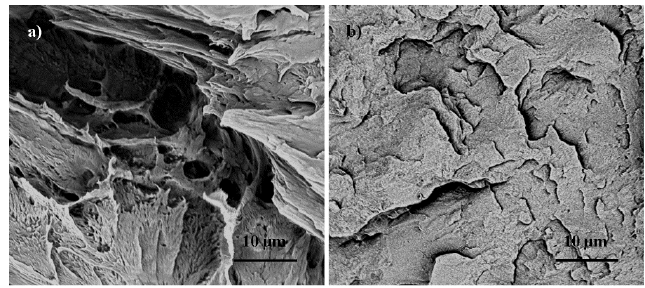
Figure 1. Representative scanning electron micrographs images of cryo-fracture surfaces for ( a ) 0 wt % cellulose nanocrystals/poly lactic acid composites (CNC/PLA) and ( b ) 3 wt % CNC/PLA composites.